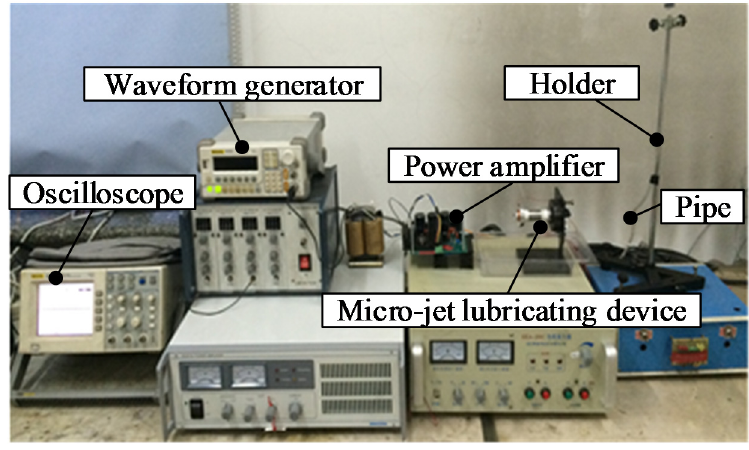
Figure 16. The experimental platform for the study of injection performance.